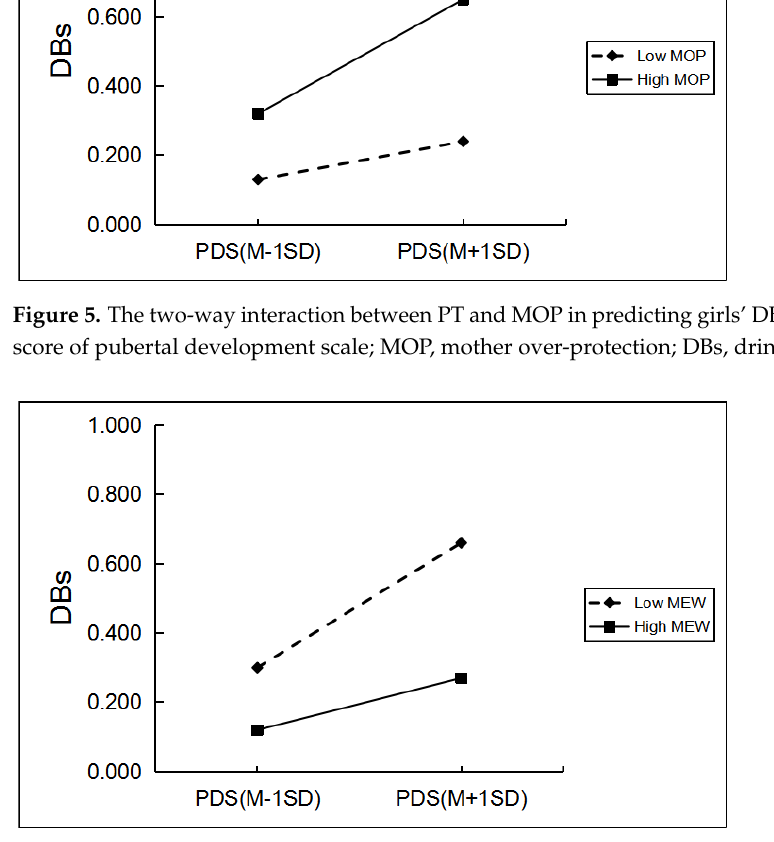
Figure 6. The two- way interaction between PT and MEW in predicting girls’ DBs. Note: PDS, the total score of pubertal development scale; MEW, mother emotional warmth; DBs, drinking behav- iors.